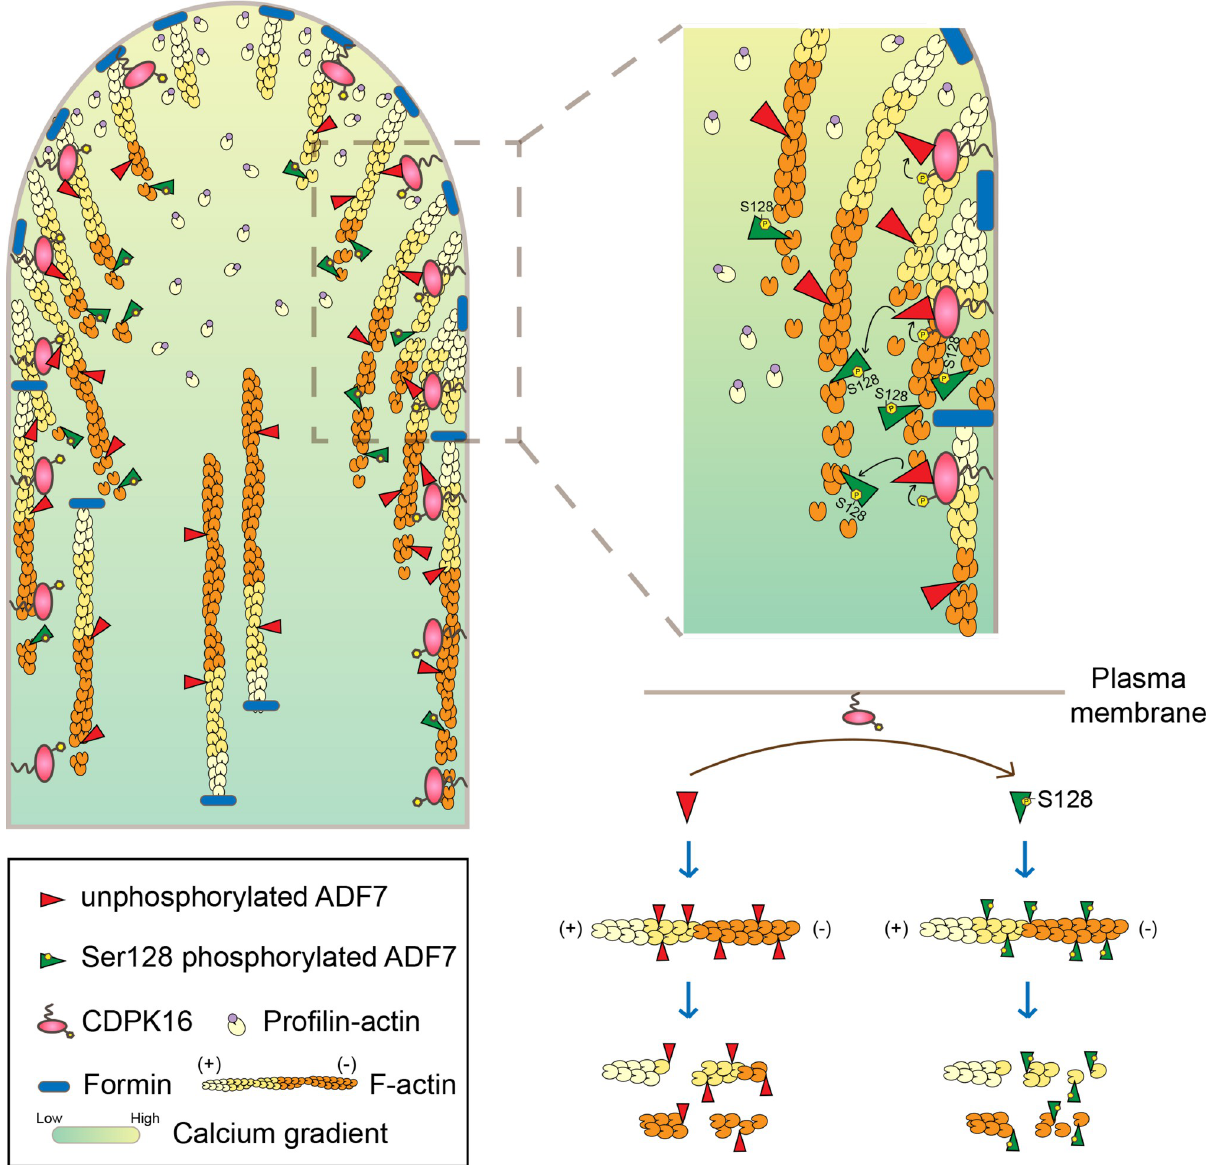
Fig 7. Schematic model illustrating the role of CDPK16 in regulating the activity of ADF7 and actin dynamics within the growth domain of pollen tubes. The left panel shows the organization of actin filaments within the apical and subapical regions of the pollen tube, where actin filaments are mainly polymerized from the PM by membrane-anchored formins utilizing profilin-actin complexes in the cytoplasm [60,74,75].ADF has been implicated in the regulation of the turnover of apical actin filaments via severing and depolymerization [11]. This limits the length of filaments and shapes their organization to form the unique “apical actin structure” [6,7]. We found here that the PM-localized CDPK16 is also involved in promoting the turnover of those PM-originated actin filaments via phosphorylation of ADF7 at Ser128 to enhance its actin severing and depolymerizing activity. The boxed region in the left panel, where CDPK16 is comparatively concentrated, is enlarged in the upper right panel. The schematic diagram in the lower right panel shows that phosphorylation of Ser128 in ADF7 enhances its actin severing and depolymerizing activity. ADF, actin-depolymerizing factor; CDPK, calcium-dependent protein kinase; PM, plasma